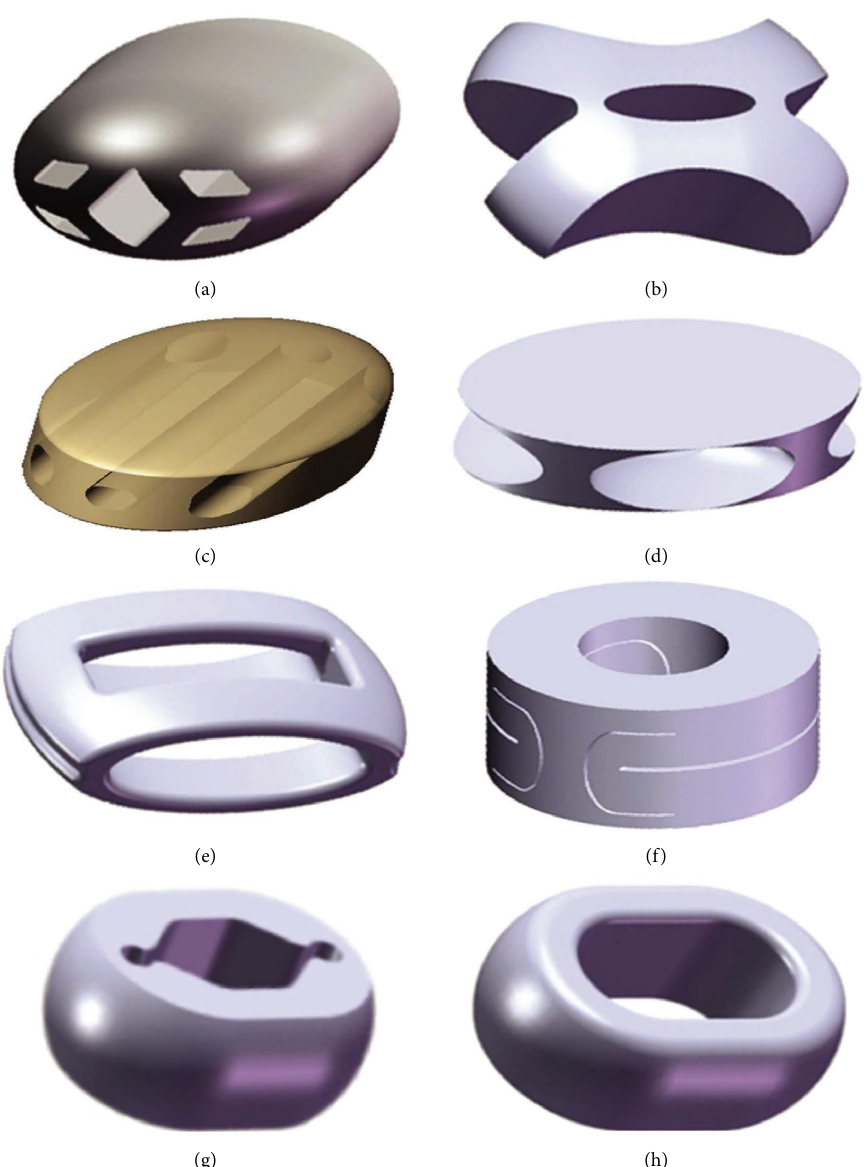
Figure 1: Monobloc designs evaluated in our study that aimed to optimize insertion and mechanical